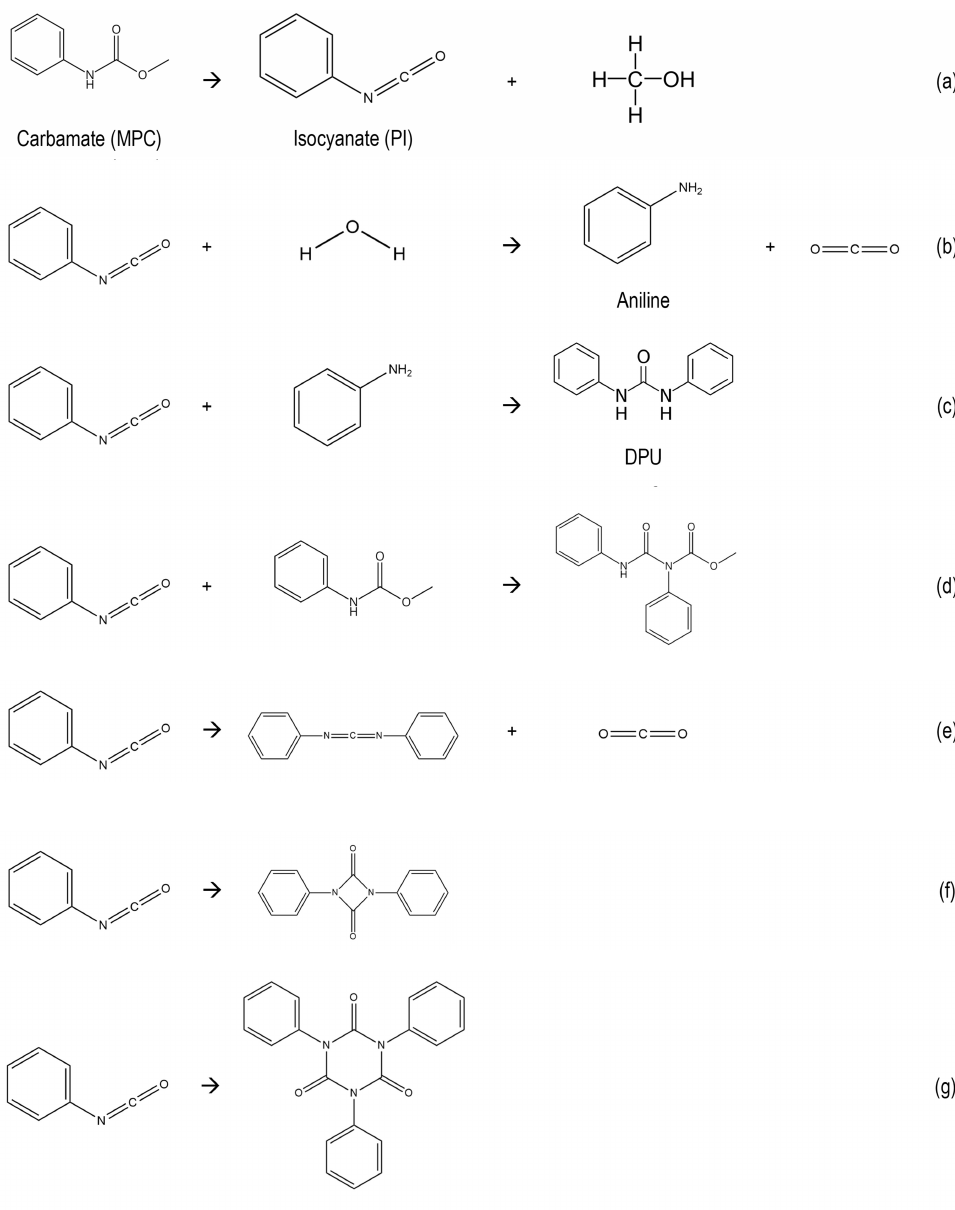
Scheme 2. Possible route of reaction of isocyanates in a carbamate thermal cracking